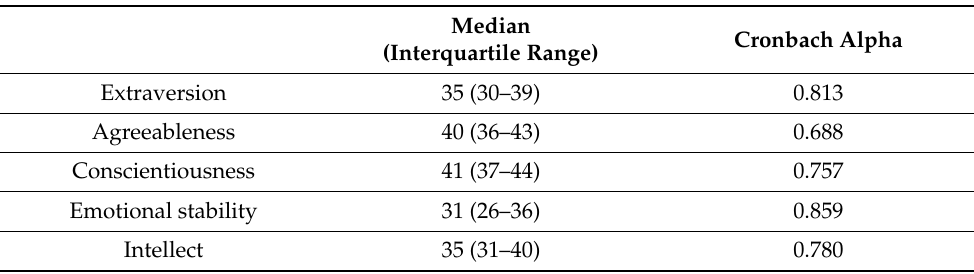
Table 8. Median and Cronbach alpha coefficient of internal consistency of reliability for each personality dimension.